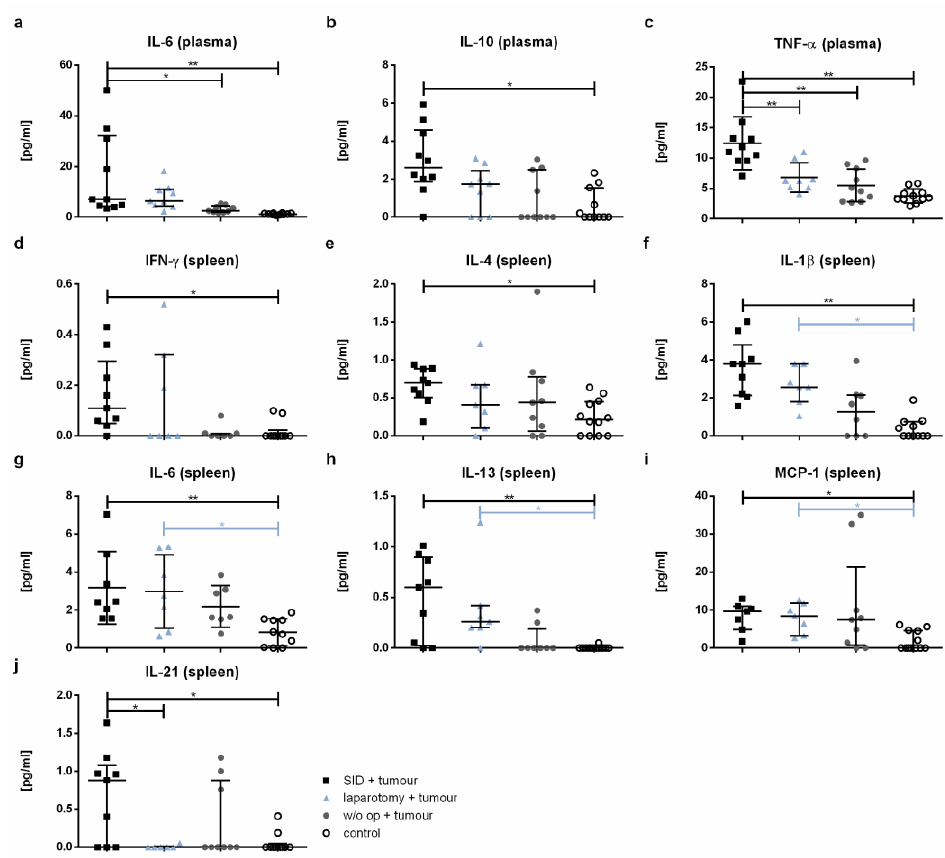
Figure 8. Cytokine level. The cytokine levels were measured by CBA in the spleen cell supernatant after 24 h incubation and in plasma. The graphics show the cytokine concentrations in pg/mL in either the plasma ( a – c ) or spleen cell supernatant (spleen; ( d – j )). Values in ( a , b , d – f , h – j ) represent the median with interquartile ranges; values in ( c , g ) are the mean and standard error with n = 7–12 animals per group (SID + tumour: n = 9; laparotomy + tumour: 7; w/o op + tumour: 8; control: 12); * p < 0.05; ** p < 0.01.